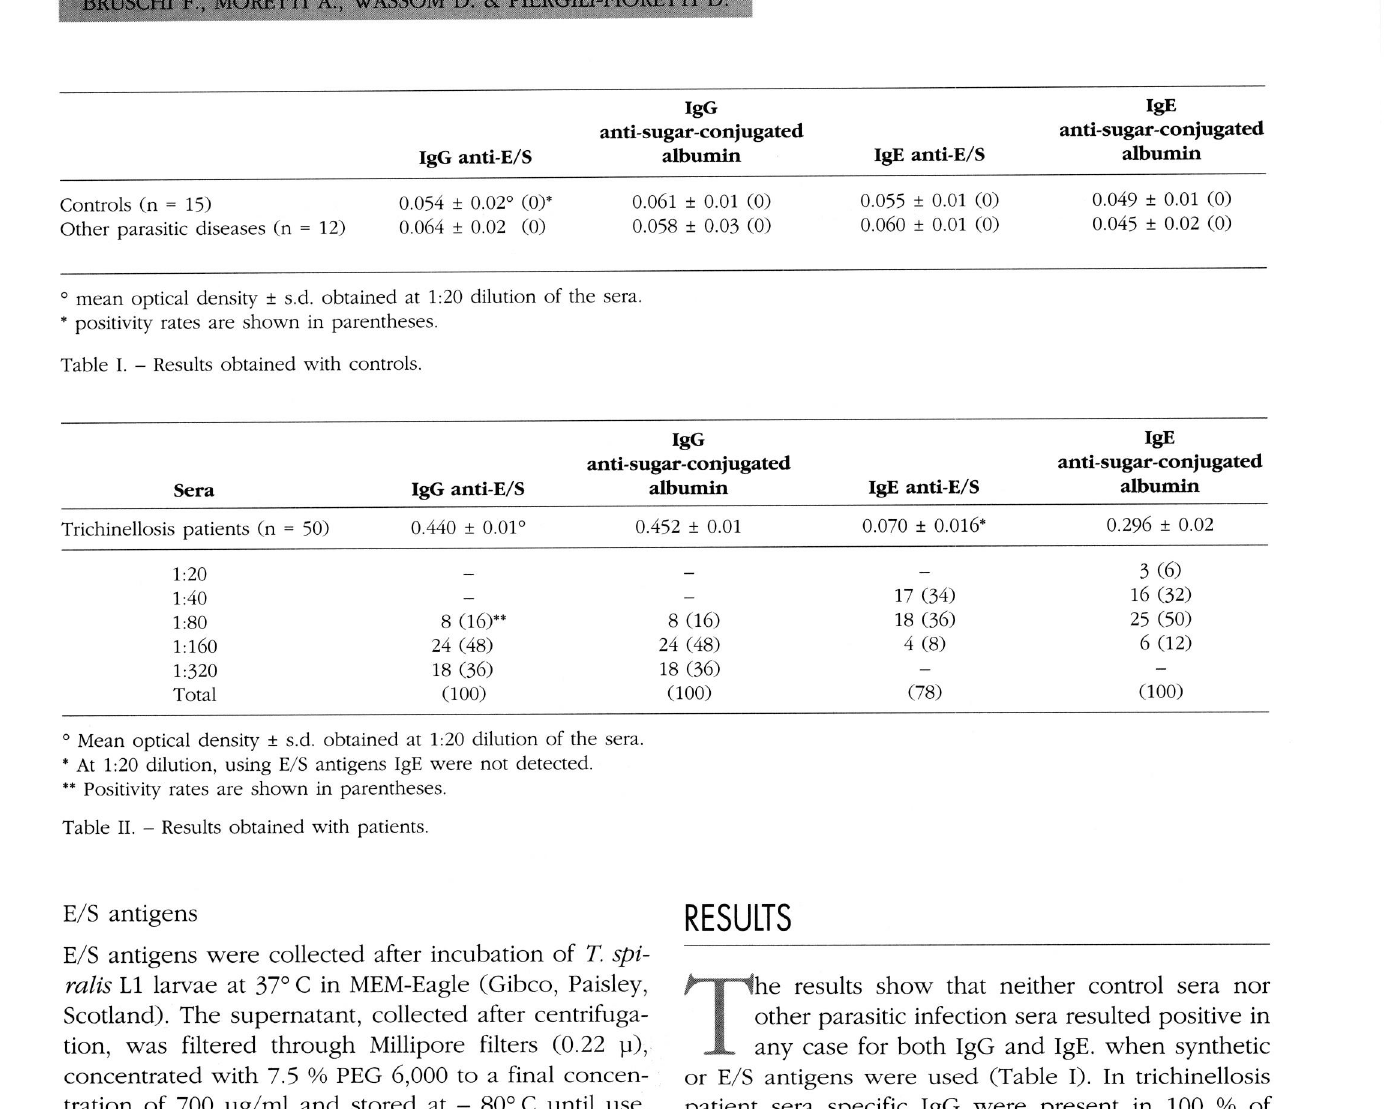
Table I. - Results obtained with controls.